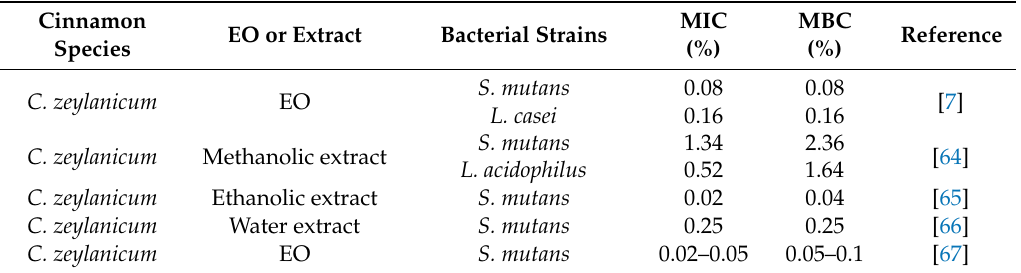
Table 2. Minimal inhibitory concentration (MIC) and minimal bactericidal concentration (MBC) of cinnamon EO and cinnamon extracts against cariogenic